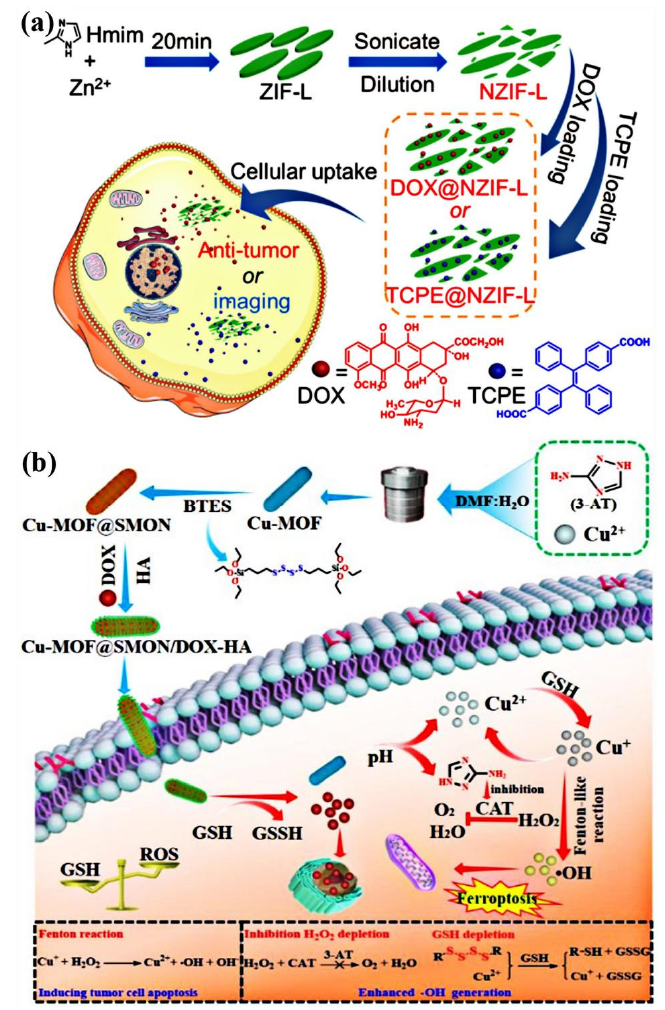
Figure 13. ( a ) The construction of NZIF-L and its application in Dox delivery and imaging. Repro- duced with permission from Ref. [85], copyright (2019) Royal Wiley-VCH. ( b ) The synthetic process of Cu-MOF@SMON/DOX-HA and its biological application. Reproduced with permission from Ref. [86], copyright (2022) the Royal Society of Chemistry.